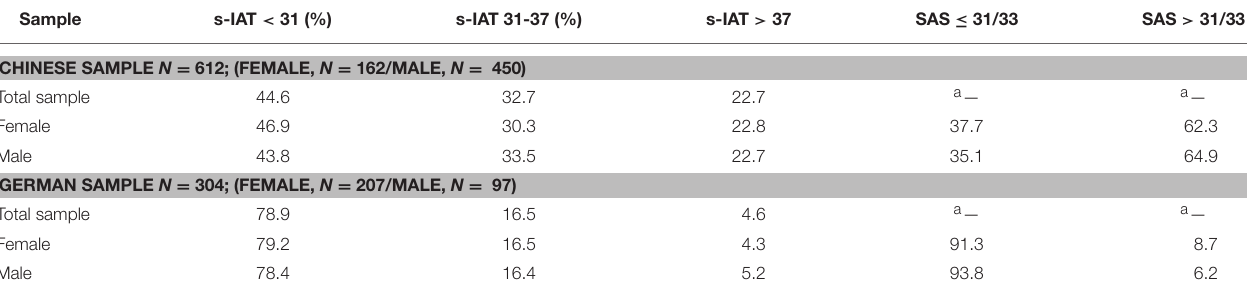
TABLE 5 | Distribution of digital use variables (s-IAT, SAS) in percent (Complete sample, female, male).